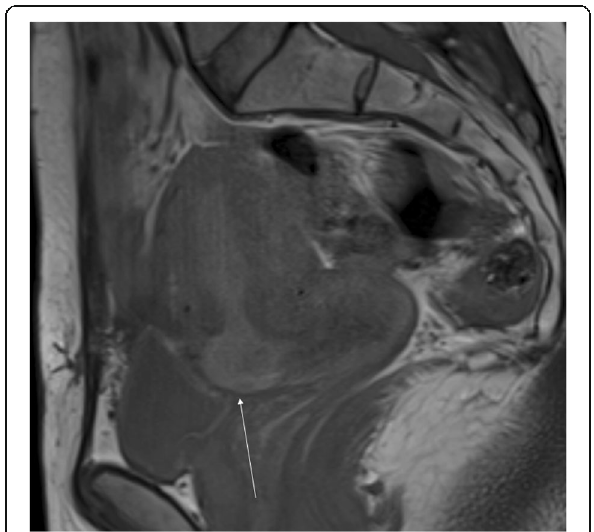
Fig. 6 Pelvic MRI, SE/T1WI in the sagittal plane. Hyperintense blood reservoir in the C-section scar defect with intact serosa (arrow), which is isointense to the